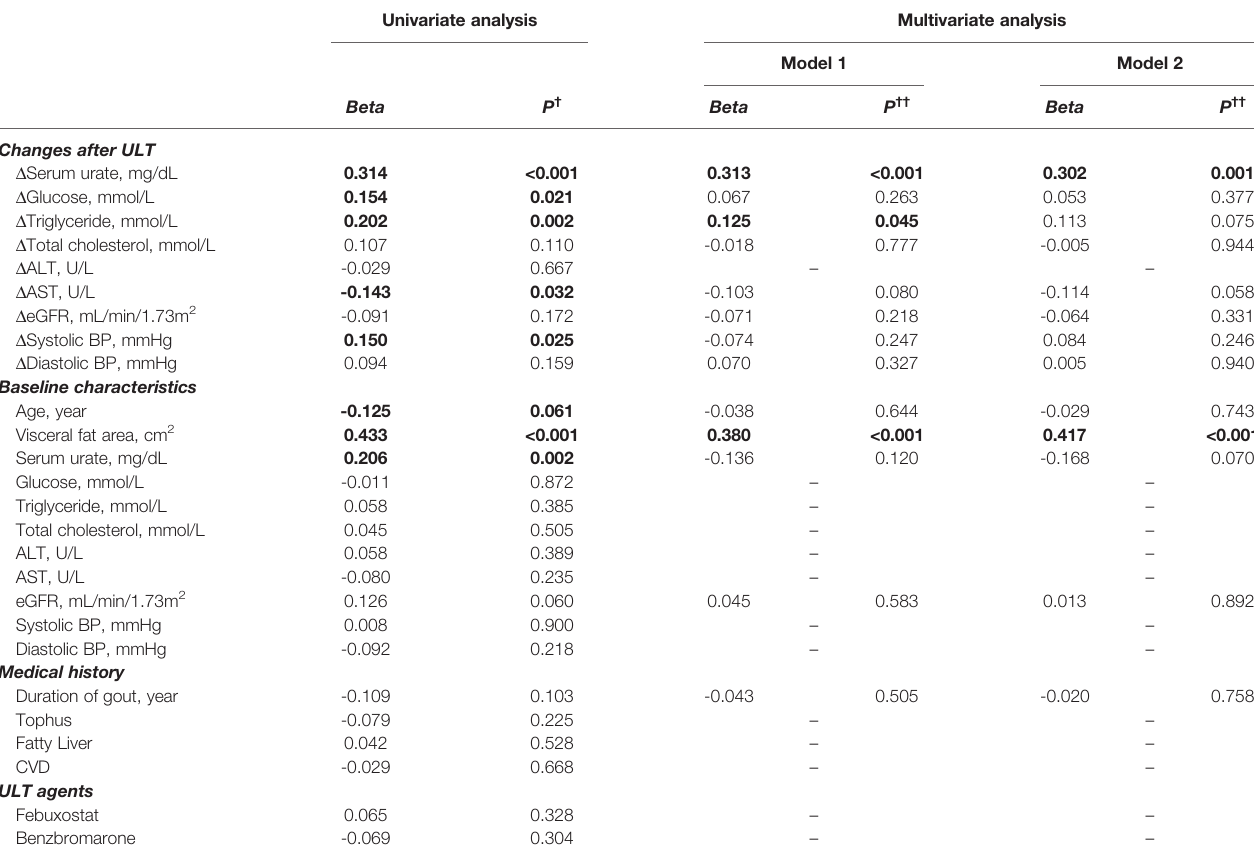
TABLE 2 | Simple and multiple linear regression of determinants of D